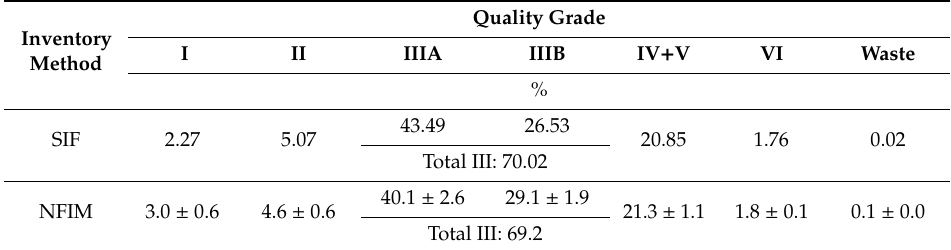
Table 1. Model distribution of coniferous growing stock by quality grades of timber assortments.